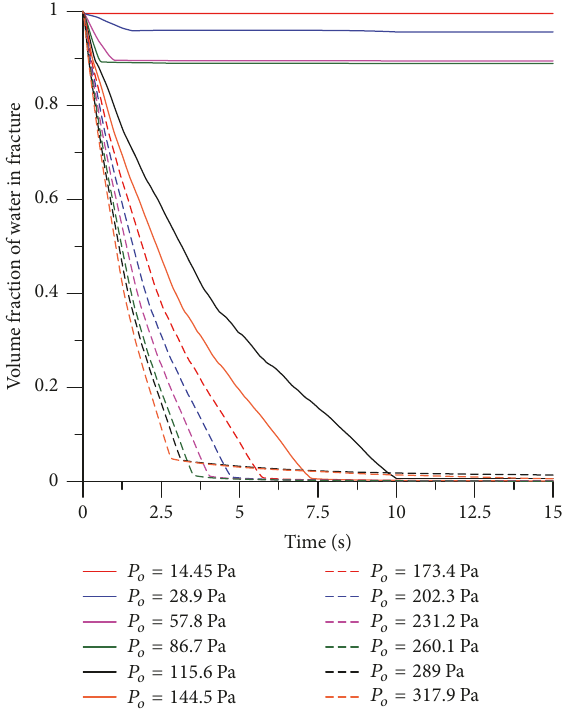
Figure 15: Volume fraction of water in a fracture with a wettable fracture wall (FD = 2.4, contact angle 60 ∘ ).